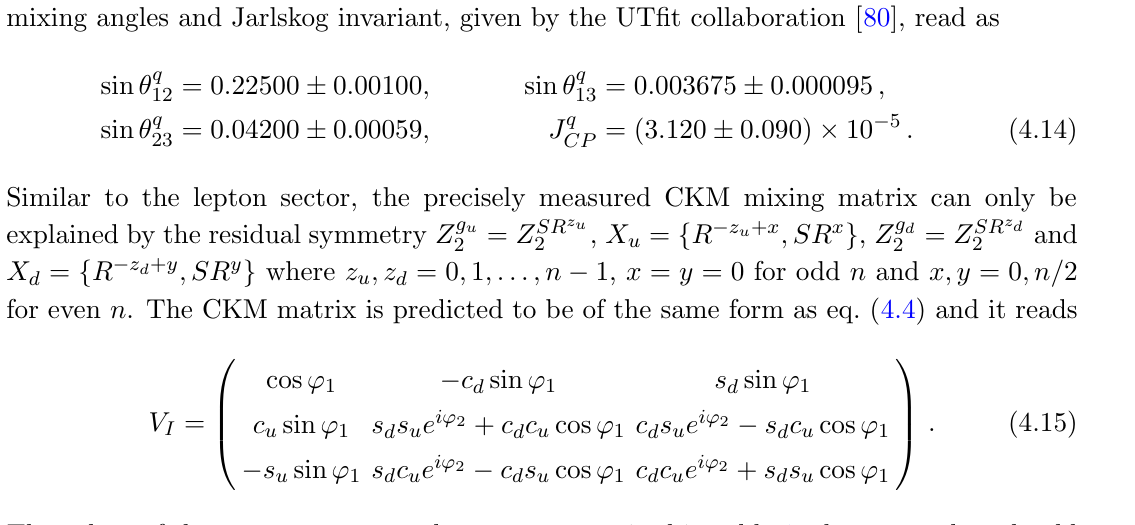
Figure 2 . The possible values of the e(cid:11)ective Majorana mass m ee as a function of the lightest neutrino mass m lightest for the mixing pattern U I; 6 with n = 4 and ’ 1 = (cid:25)= 4, ’ 2 = (cid:25)= 2. The red (blue) dashed lines indicate the most general allowed regions for IO (NO) neutrino mass spectrum obtained by varying the mixing parameters over their 3 (cid:27) ranges [2]. The present most stringent upper limits j m ee j < 0 : 120 eV from EXO-200 [76, 77] and KamLAND-ZEN [78] is represented by horizontal grey band. The vertical grey exclusion band denotes the current bound coming from the cosmological data of P m i < 0 : 130 eV at 95% con(cid:12)dence level obtained by the Planck collaboration [79], the dashed and solid black lines are for IO and NO respectively. mixing angles and Jarlskog invariant, given by the UT(cid:12)t collaboration [80], read